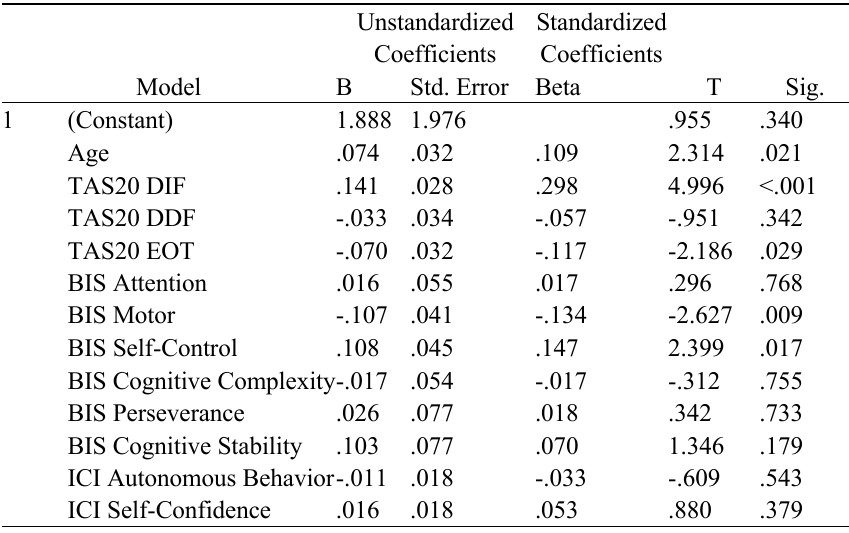
Table 4. Coefficients a of Multiple Regression Analysis with Subscales of TAS20,